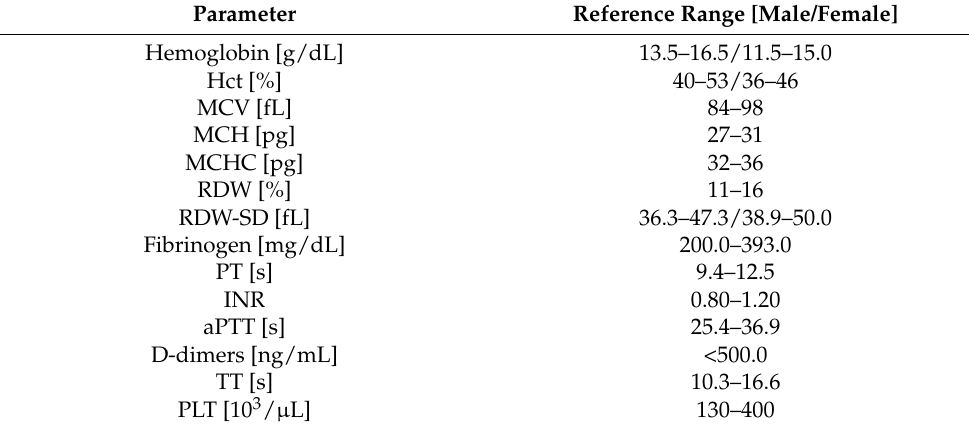
Table 1. Local laboratory reference ranges for analyzed